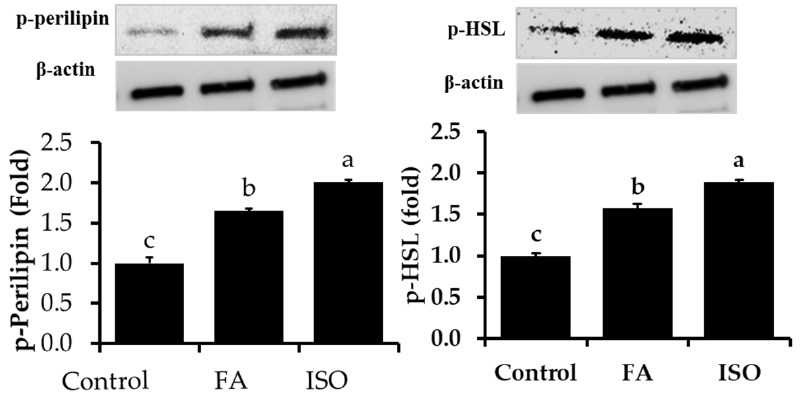
Figure 2. Phosphorylation levels of perilipin and hormone-sensitive lipase (HSL) were determined in experimental 3T3-L1 adipocytes with or without FA and ISO. The results are represented as the mean ± standard error of the mean three replicates. a,b,c p < 0.05 statistically significant difference between control and treated groups.